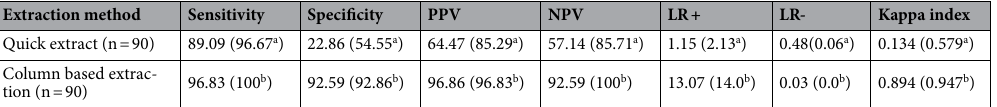
Table 3. Operating characteristics of in-house SYBR green assay. PPV positive predictive value, NPV negative predictive value, LR + positive likelihood ratio, LR − negative likelihood ratio. a Considering Sansure for condodant samples and S gene amplification for contradictory false-positive and negative samples as the standard, respectively. The sample number here would be 82 (n = 82) due to undetermined results of eight samples in spike amplification step. b Considering Sansure as standard for 86 concordant samples and S gene amplification as standard for the four contradictory samples. The sample number would be 89 (n-89) here due to one undetermined result in PCR and gel